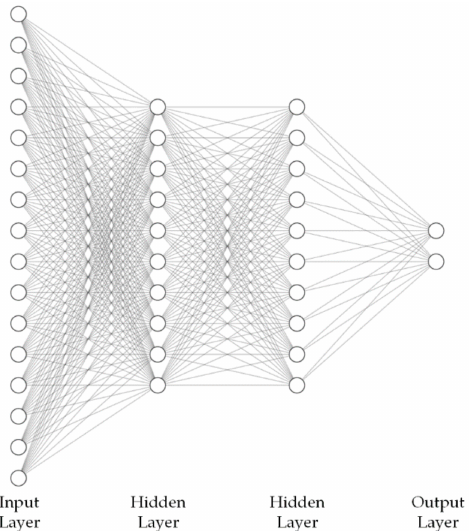
Figure 6. Layer diagram representation of the basic DSD MLP-based system, using between 2 and 3 hidden layers with 64 or 128 nodes per layer, and with an output layer of size 2, the number of classes taken into account ( truthful and deceptive ), and applying the “softmax” activation